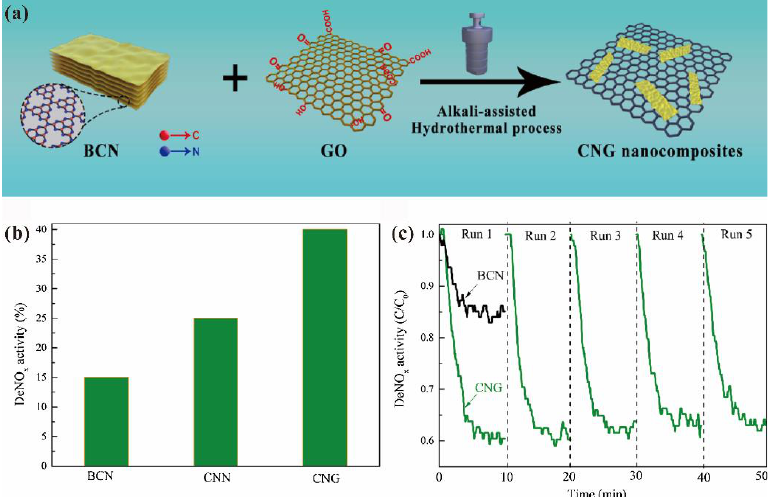
Figure 16. ( a ) Schematic illustration for the preparation of g − C 3 N 4 /rGO nanocomposites using an alkali − assisted hydrothermal method. ( b ) Photocatalytic performance of pristine g − C 3 N 4 and g − C 3 N 4 treated using an alkali-assisted process and g − C 3 N 4 /rGO for the removal of NO irradiated under visible light. ( c ) Stability test of g − C 3 N 4 /rGO [122]. Copyright 2020, Elsevier.